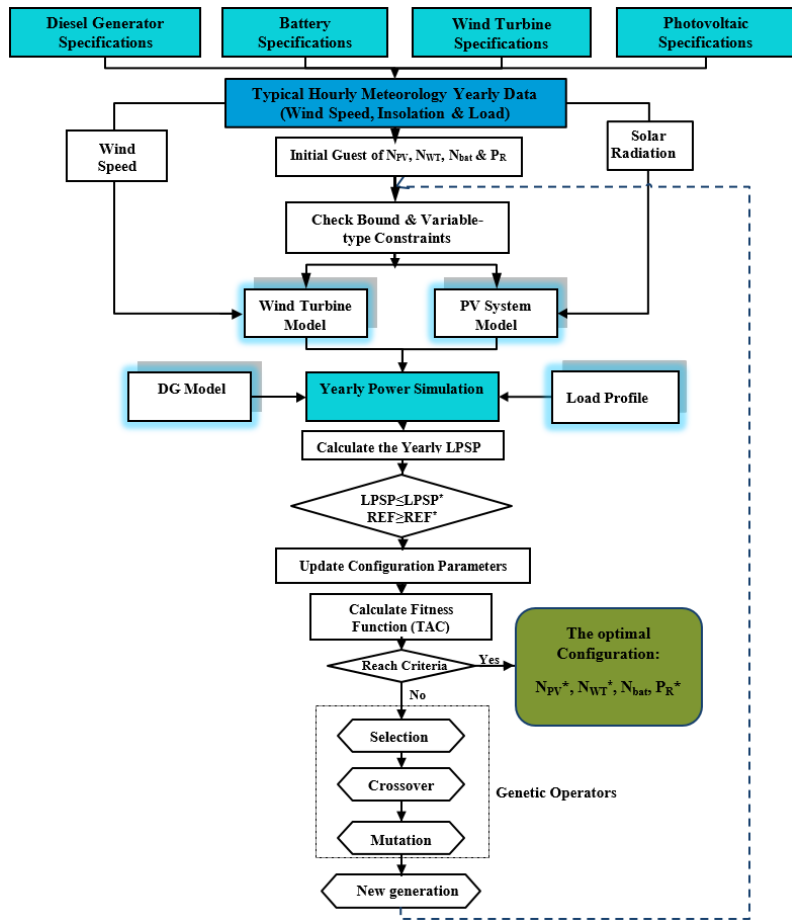
Figure 6. Flow chart of the optimization process using a genetic algorithm.